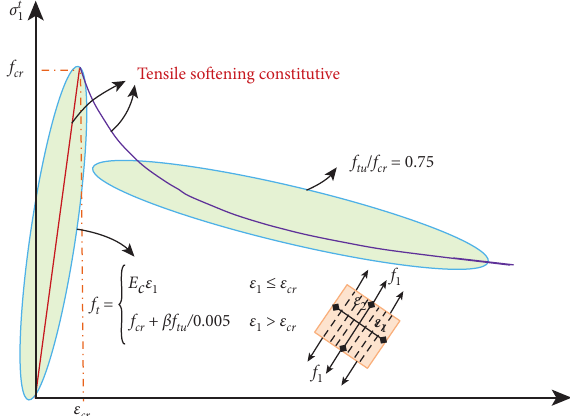
Figure 4: Compression constitutive model of UHPC in the biaxial stress state.